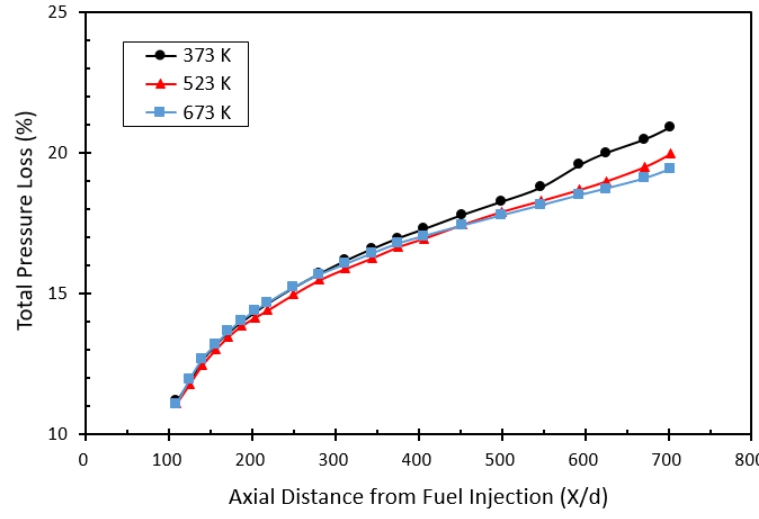
Figure 11. Comparison of total pressure losses downstream of the pylon for three different air tem- peratures.